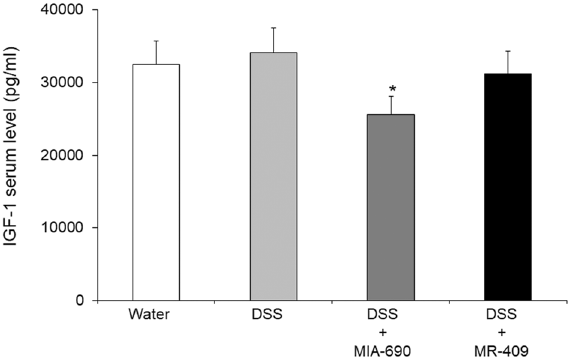
Figure 11. Effects of MIA-690 (5 μg) and MR-409 (1-5 μM) on IGF-1 levels in serum of DSS-treated mice (n = 6 for each group of treatment) as determined by ELISA kit. Data are expressed as means ± S.E.M. and analyzed by analysis of variance (ANOVA) followed by Bonferroni post-hoc test * p < 0.05 versus water controls, DSS or DSS + MR-409 treated mice.